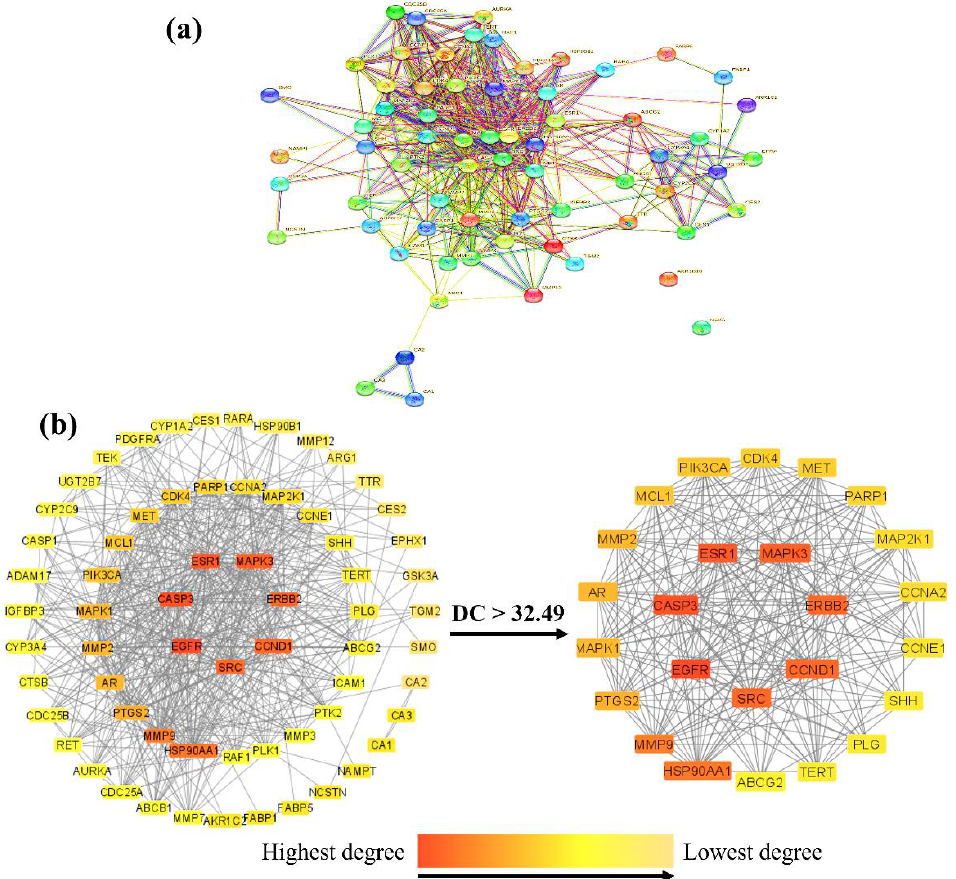
Figure 3. ( a ) PPI network of 67 intersecting targets constructed with STRING. ( b ) The PPI network of the 67 intersecting targets and the 25 potential anti-HCC core targets was constructed using Cytoscape software. Each node’s color denotes the degree, from red (highest) to yellow (lowest), as the node degree